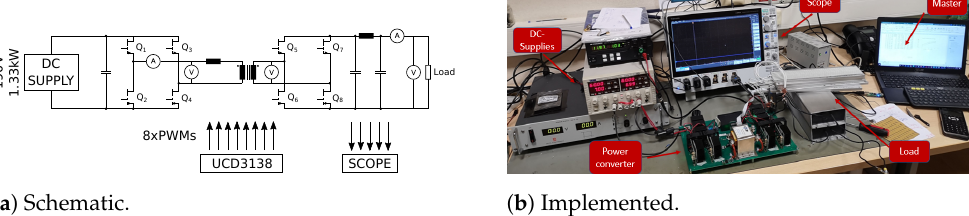
Figure 17. Measurement setup for prototype functionality test at reduced